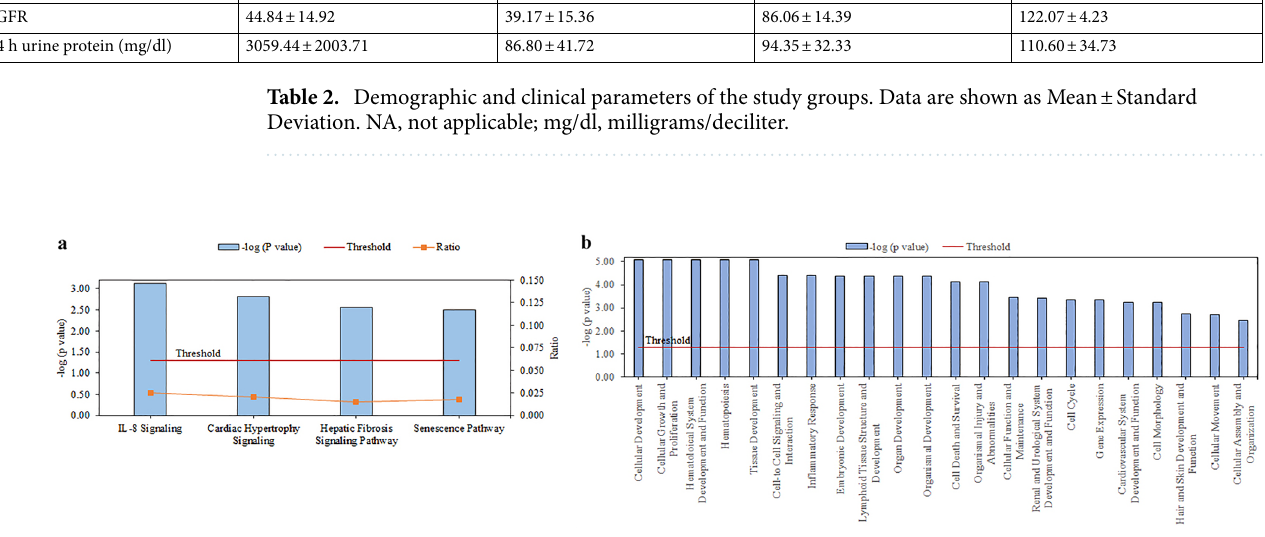
Figure 4. Core Analysis of miR-663a target genes by Ingenuity Pathway Analysis Software. The plausible targeted genes of miR-663a were analyzed for Core Analysis by Ingenuity Pathway Analysis software which yielded ( a ) 4 enriched canonical pathways. ( b ) Significant 22 diseases and functions. Blue bars represent the p- value for each pathway as well as disease and functions and are expressed as − log ( p- value). The threshold line corresponds to 0.05 (red line). The ratio (orange points) on each pathway represents the ratio of the number of genes from the dataset that meet the cut-off criteria divided by the total number of genes that map to that pathway from the Ingenuity Knowledge Database. p < 0.01 and number of molecules ≥ 5 were the criteria for selecting canonical pathways as well as disease and